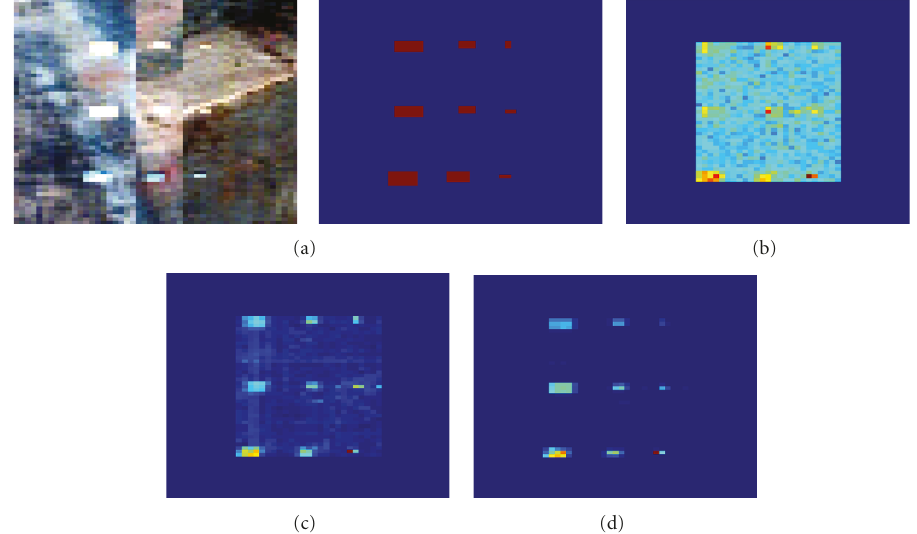
Figure 1: Comparison of RX and LAIRX. (a) Original test image with truth mask, (b) RX scores, (c) RX using 1st 10 Principal Components, (d) LAIRX scores.